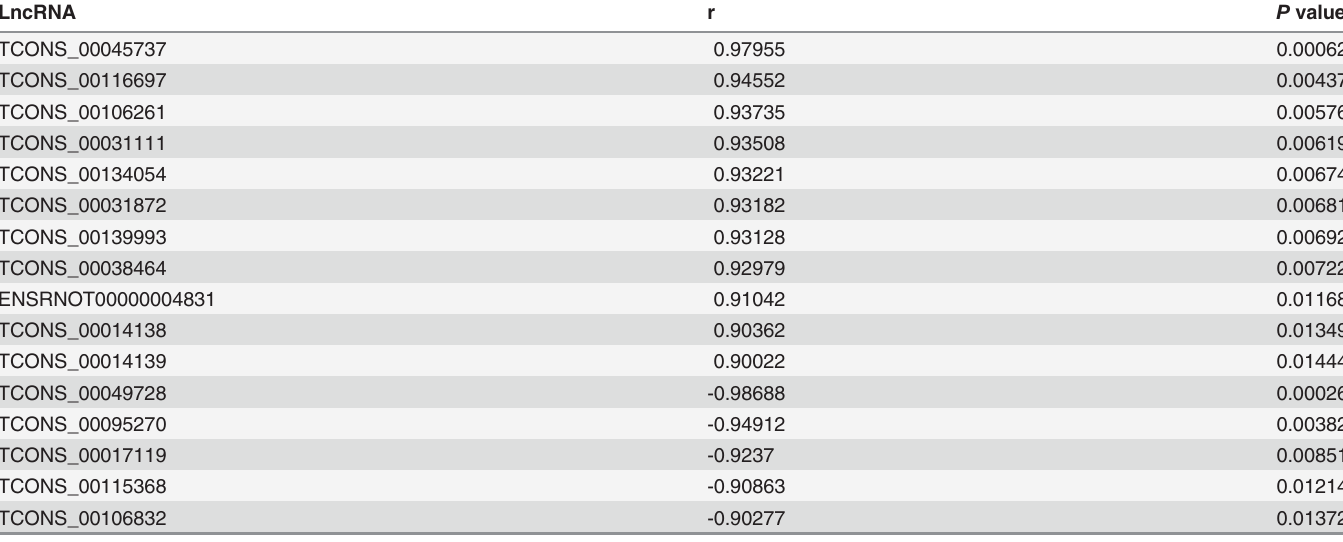
Table 5. The relationship of differentially expressed lncRNAs with the mRNA expression of MAPK4.